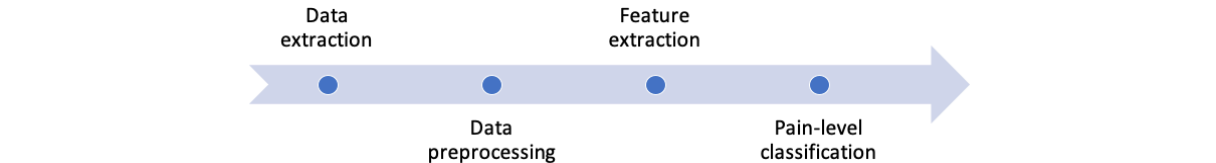
Figure 5. Block diagram of planned